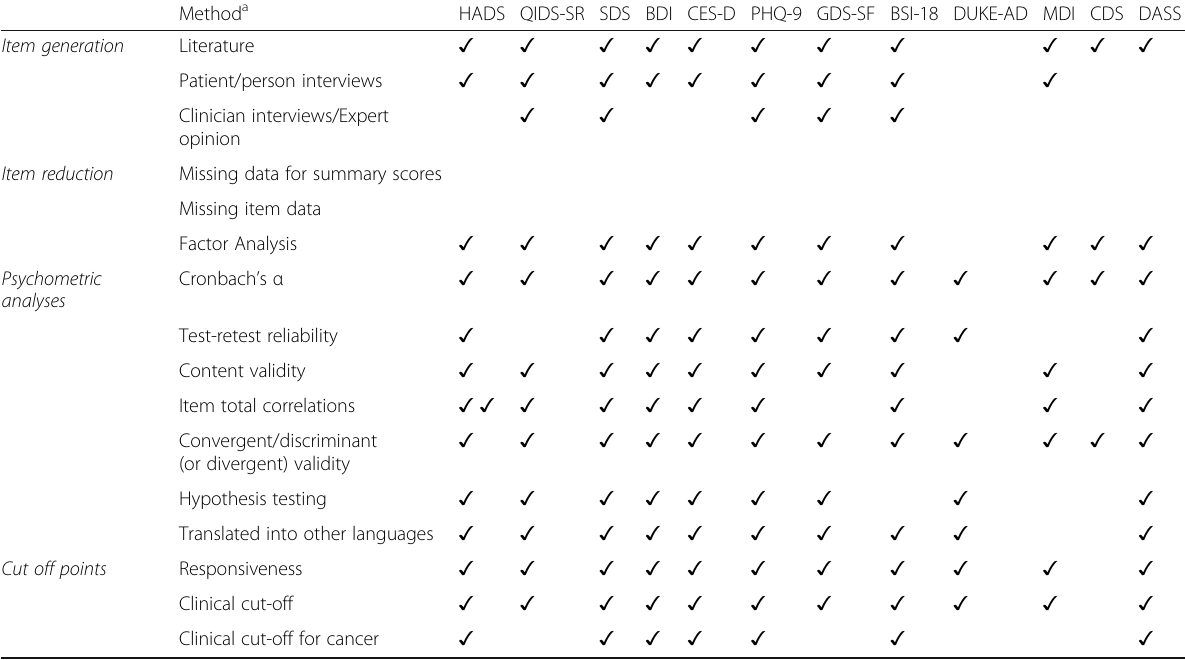
Table 4 Patient reported outcome measures of depression: measurement